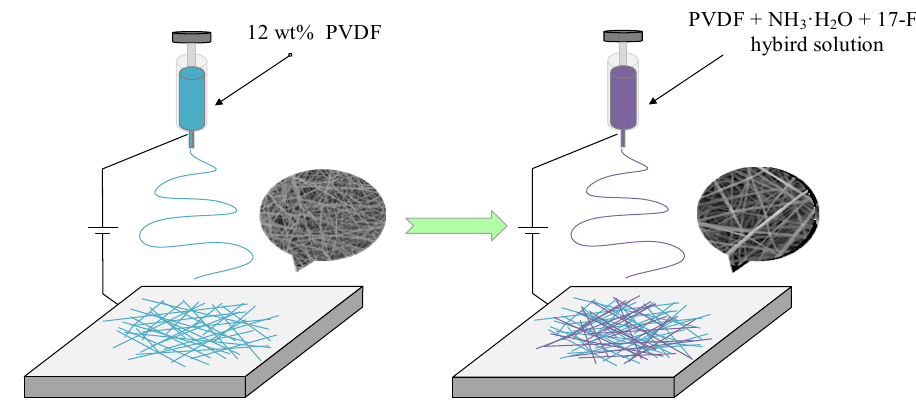
Figure 1. Fabrication procedures of the omniphobic membrane.